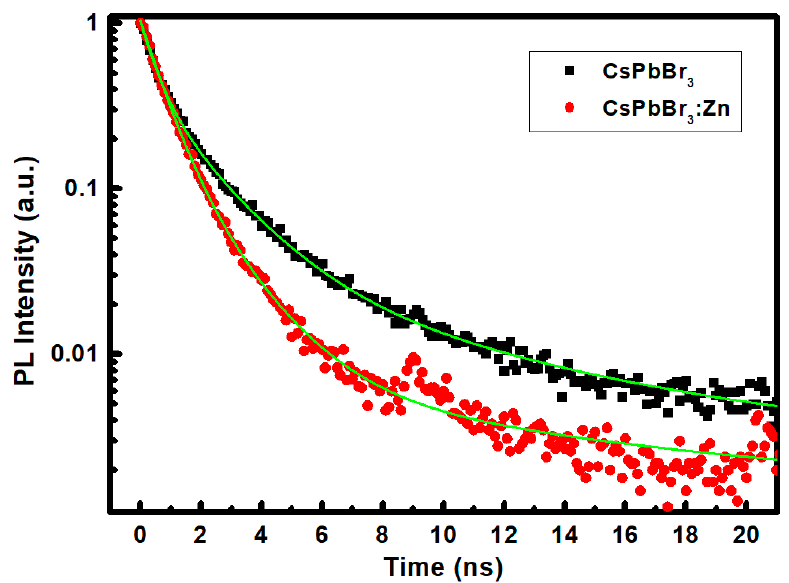
Figure 4. TRPL spectra of the CsPbBr 3 and CsPbBr 3 :Zn NC solutions, respectively. In evaluating the water-resistance ability of NCs, initially, 1 mL of water was added into the NC solutions with the same NC concentration. As shown in Figure 5, the NCs dispersed in hexane were not affected by the water addition due to the great difference in solvent polarity. As a result, no obvious decrease of the PL intensity from the NCs was observed for several days (not shown). To accelerate the hydrolysis reaction, 200 µ L of ethanol were injected into each of the solutions, and then, as shown in the figure, the NCs turned to be yellowish within a few minutes, whereas the CsPbBr 3 :Zn NCs kept their green color. Both solutions appeared turbid because of decomposition (back to PbBr 2 and CsBr) and aggregation of NCs [24]. Within one day, the decrease of concentration and PL intensity of CsPbBr 3 NCs were clearly observed, and eventually, the solution with no NC dispersion became transparent again. The entire degradation process was significantly prolonged for CsPbBr 3 :Zn NCs to over four days. The precipitated white product, mainly the PbBr 2 (because CsBr is highly dissolvable in water), accumulated at the solvent interface. From the above demonstration, it is evident that the surface passivation of Pb vacancies by Zn atoms is an excellent strategy to increase the water-resistance ability of AILHP NCs. Presumably, the Pb vacancy without surface ligands plays a role of breaking point for the water penetration and subsequent interaction between AILHP and